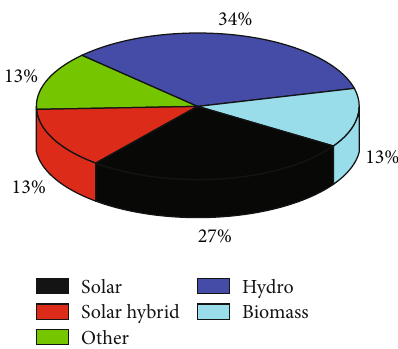
Figure 4: Minigrids in Uganda by resource utilized.